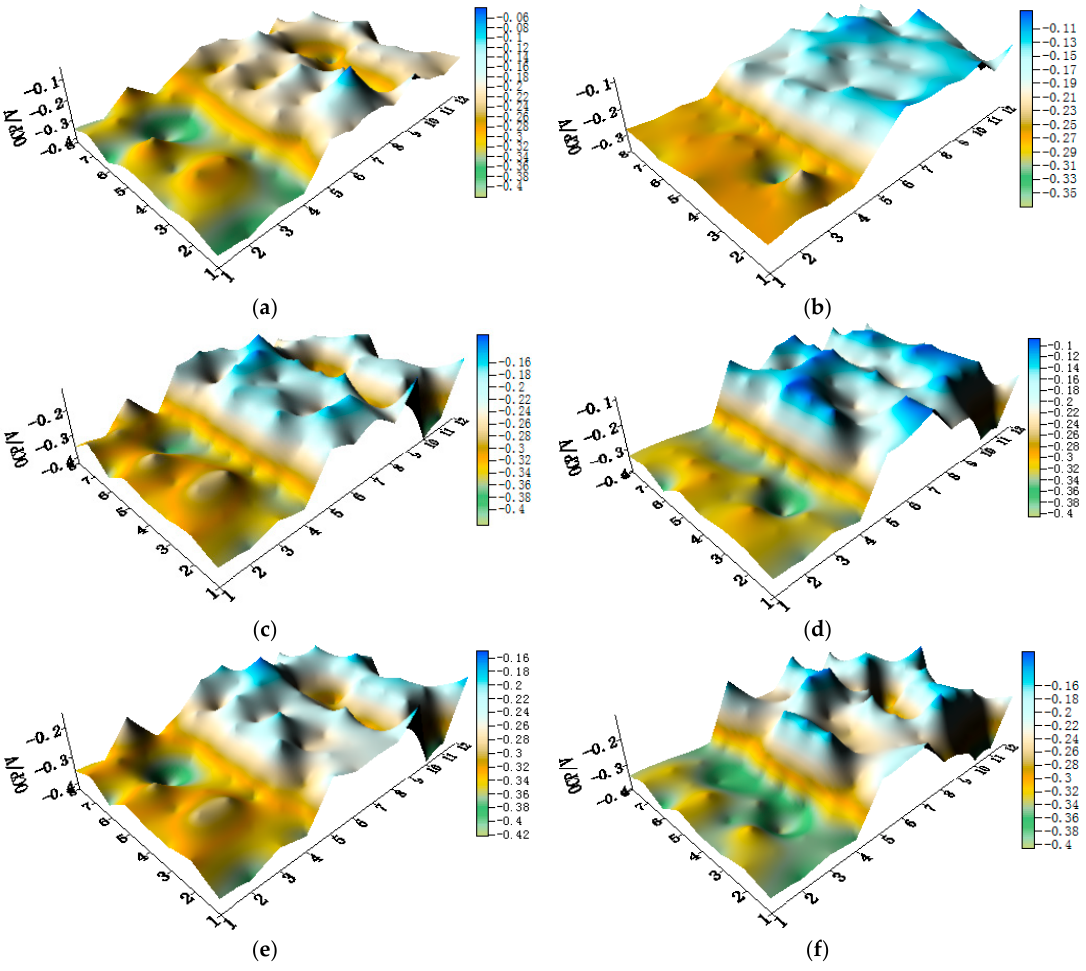
Figure 7. OCP (vs. SCE/V) distribution maps of CMEA2 after immersion in artificial seawater with different concentrations of chloride ions (wt %): ( a ) 1.5%; ( b ) 1.7%; ( c ) 1.9%; ( d ) 2.1%; ( e ) 2.3%; and ( f ) 2.5%.